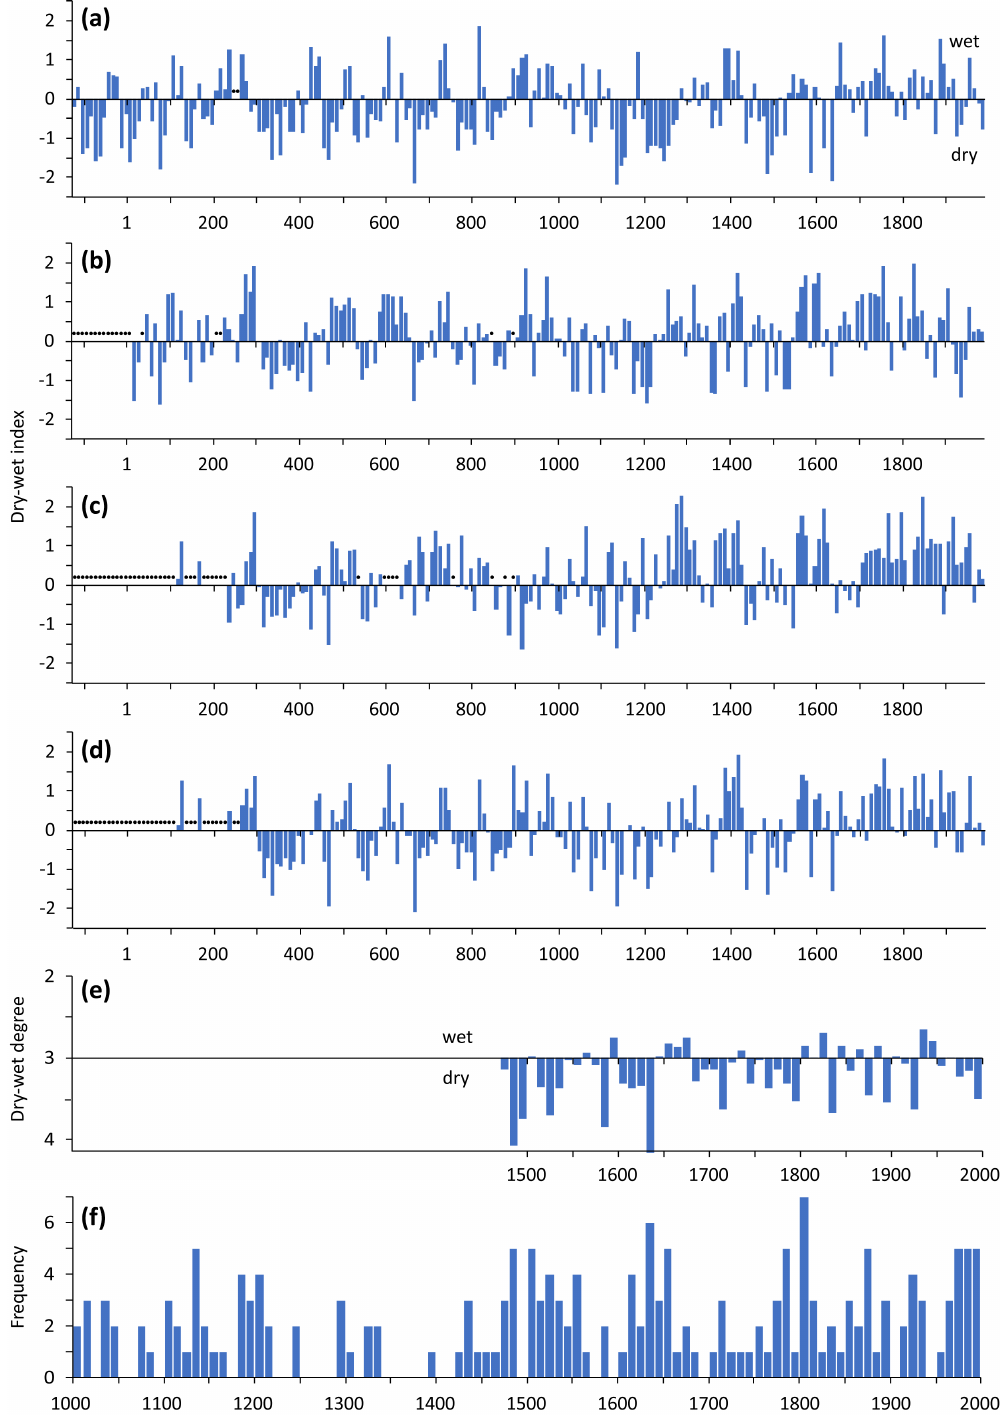
Figure 10. Long-term fluctuations in a range of documentary-based drought series across China: decadal means of regional dry-wet index series for the North China Plain (a) , Jiang-Huai area (b) , Jiang-Nan area (c) and (central) eastern China (d) over the past 2000 years with missing or incomplete decades marked by points (Ge et al., 2014, 2016); (e) decadal means of degrees of dryness/wetness (2 – wet; 3 – normal; 4 – dry; see Sect. 4.1.2) in the Great Bend of the Yellow River region, 1470–2000 (Yang et al., 2014); (f) decadal frequencies of droughts in the Yangtze Delta, 1000–2000 (Jiang et al.,